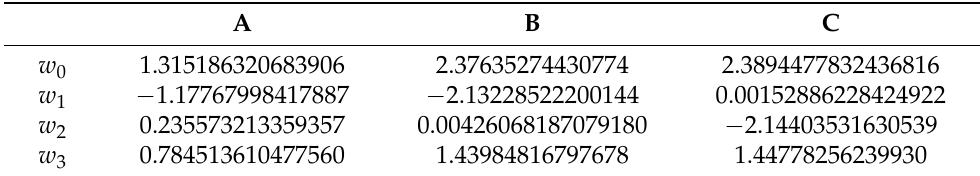
Table 1. The coefficients w i for three different 6th order